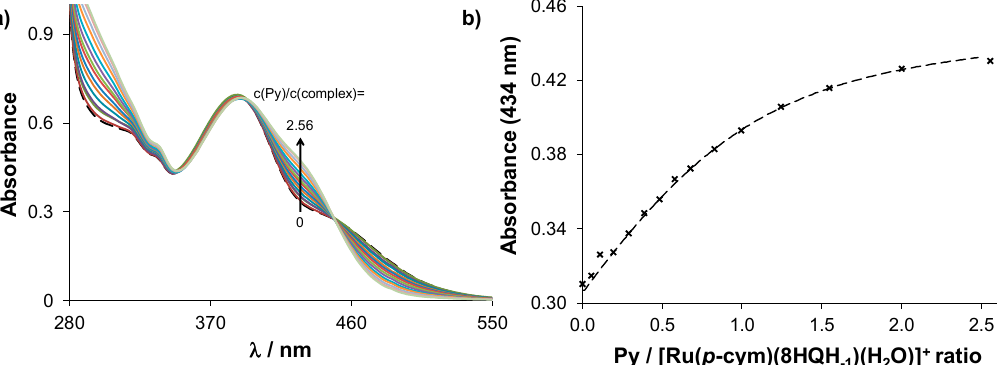
Figure 3. ( a ) UV ‐ vis spectra of c ([Ru( p ‐ cym)(8HQH ‐ 1 )(H 2 O)] + ) at various pyridine concentrations at pH = 5.95 (PBS’ buffer)). ( b ) Absorbance values at 434 nm as the function of c (Py)/ c (aqua complex) ratio. { c ([Ru( p ‑cym)(8HQH ‑1 )(H 2 O)] + ) = 200 µ M; pyridine: 0–2.56 equivalents; pH = 5.95 (PBS’); ◦ t = 25 C; ℓ = 1